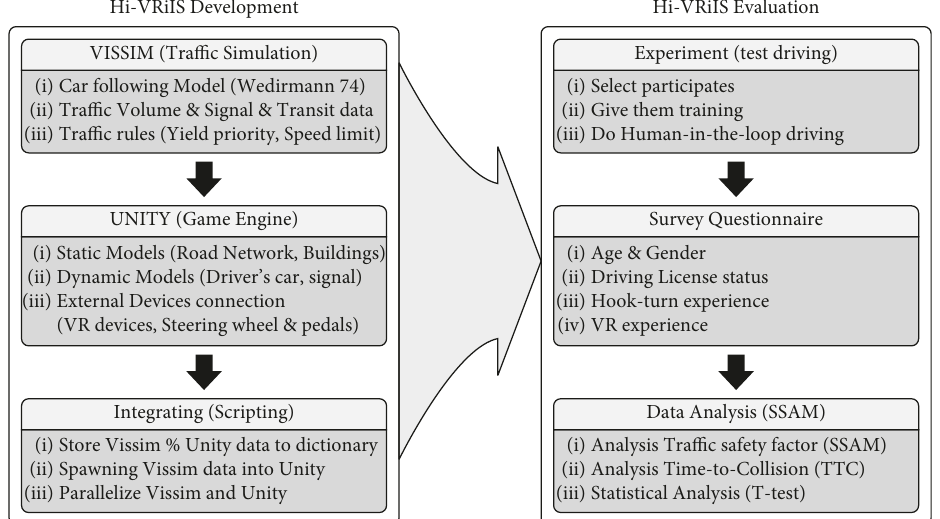
Figure 2: The development and the evaluation process of